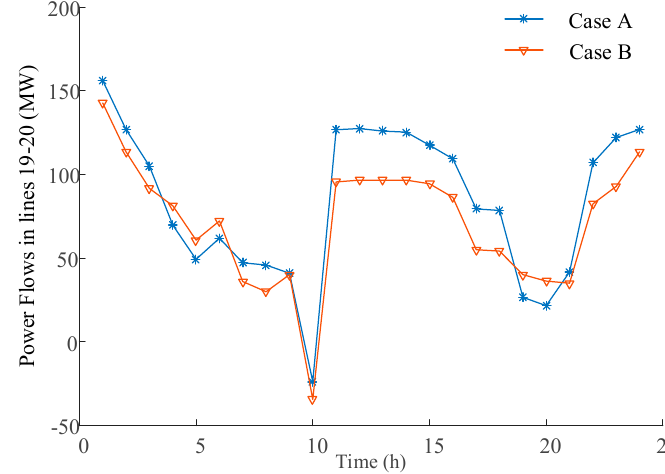
Figure 9. Power flows in line 19–20 in day-ahead scheduling stage.